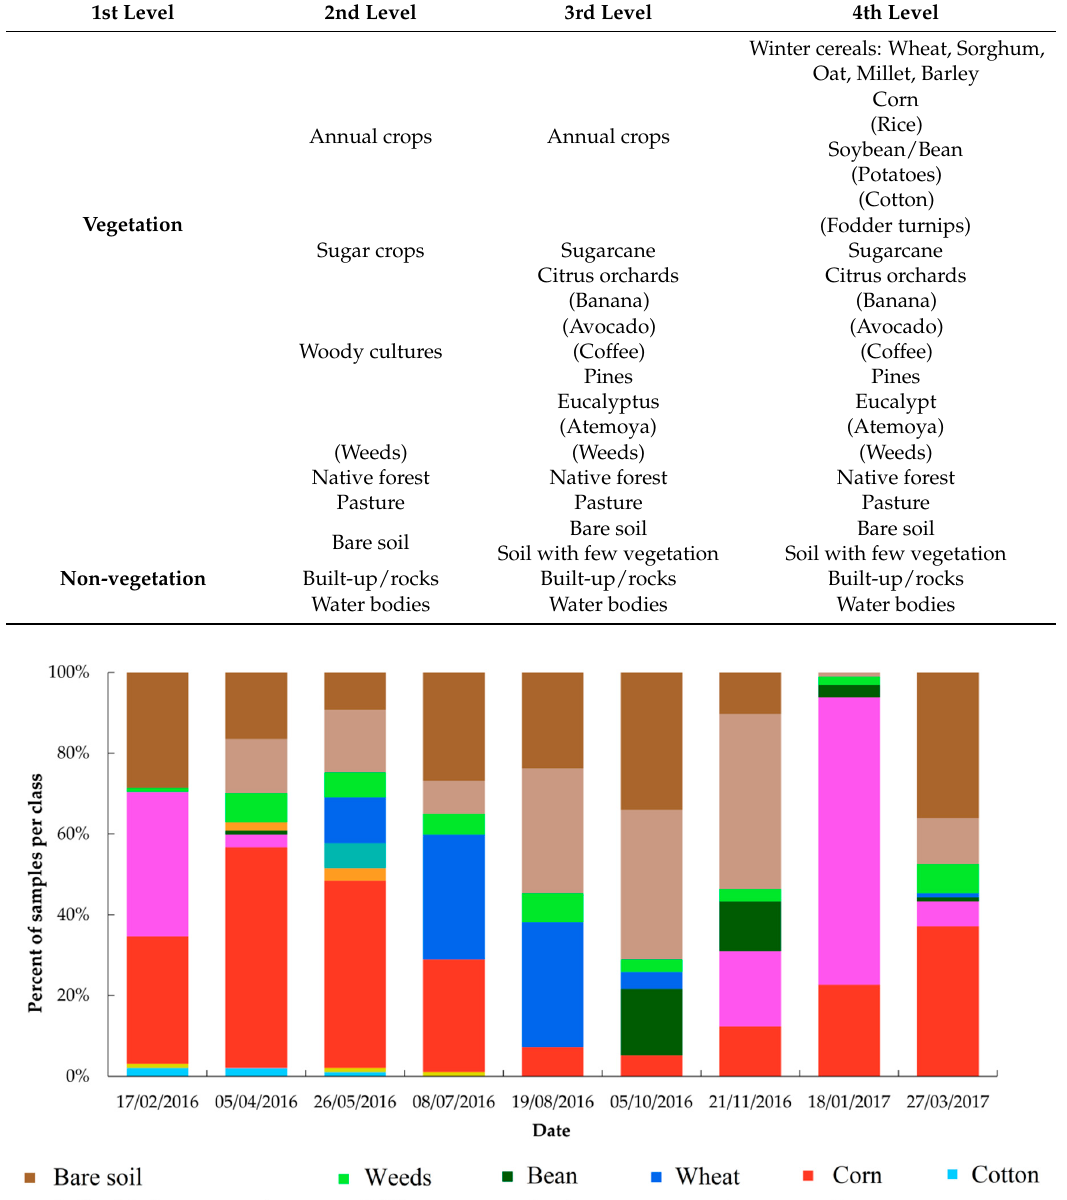
Table 1. Nomenclature used in this study showing the four different levels of classification. Classes in parenthesis were seldom observed and were, therefore, not used in the supervised classification.